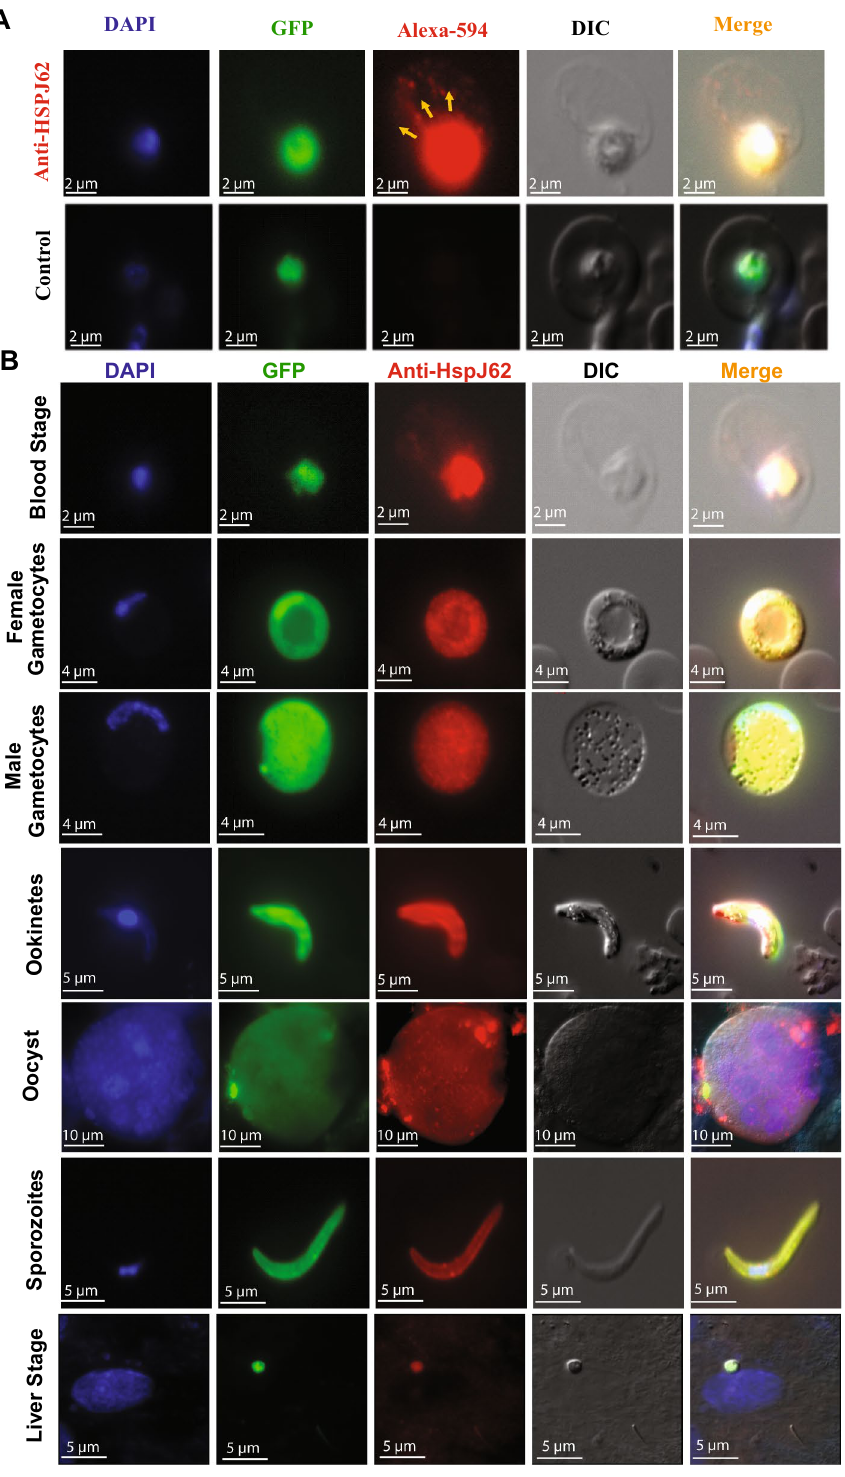
Figure 2. HspJ62 is expressed throughout the different stages of the parasite life cycle. ( A ) Representative cells show the export of protein across the PV membrane into the host cytosol. An anti-HspJ62 polyclonal antibody was used as the primary antibody, followed by an Alexa 594-conjugated secondary antibody. The parasite nuclei were stained with DAPI (blue), and the slides were visualized under a fluorescence microscope. Preimmune rat sera were used as a negative control. ( B ) Immunofluorescence assays to localize HspJ62 in the different developmental stages of parasites using anti-HspJ62 antibodies. The WT-GFPcon parasites (green) were used for IFA, and an anti-rat Alexa 594-conjugated secondary antibody (red) was used to detect the expression and localization of HspJ62 in all stages of P. berghei . The parasite nuclei were stained with DAPI (blue), and the slides were visualized under a fluorescence microscope. Preimmune rat sera were used as a negative control (Supplementary Fig.